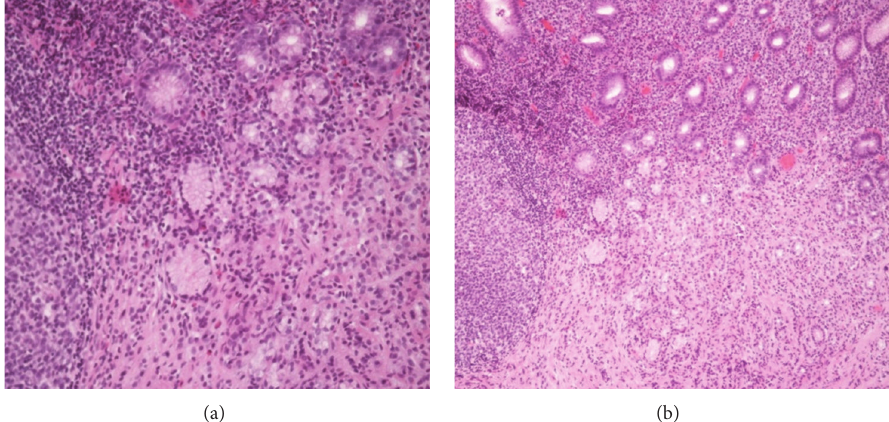
Figure 2: A well-differentiated neuroendocrine tumor consistent with carcinoid